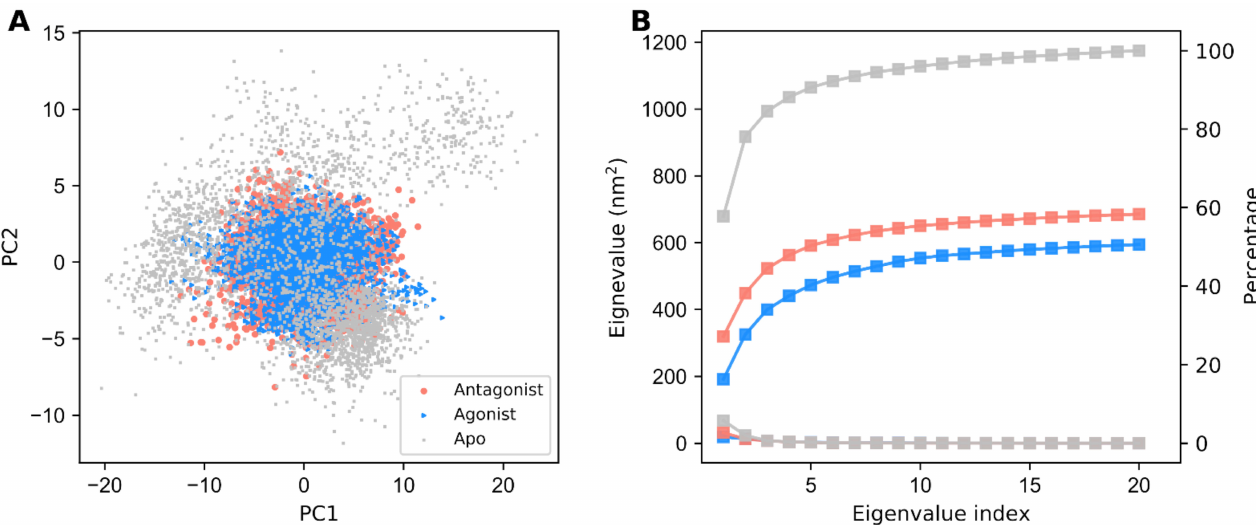
Figure 3. Principal component (PC)1 and PC2 projections of the different structural conformations of GDH states. ( A ) Two-dimensional (2D) projection of PC1 and PC2 throughout the MD simulations for the apo, agonist-bound, and antagonist- bound GDH states, which are represented in gray, dodger blue, and salmon, respectively. ( B ) The best PCs of eigenvalues corresponding to the first 20 eigenvectors and their related cumulative fluctuations are represented by